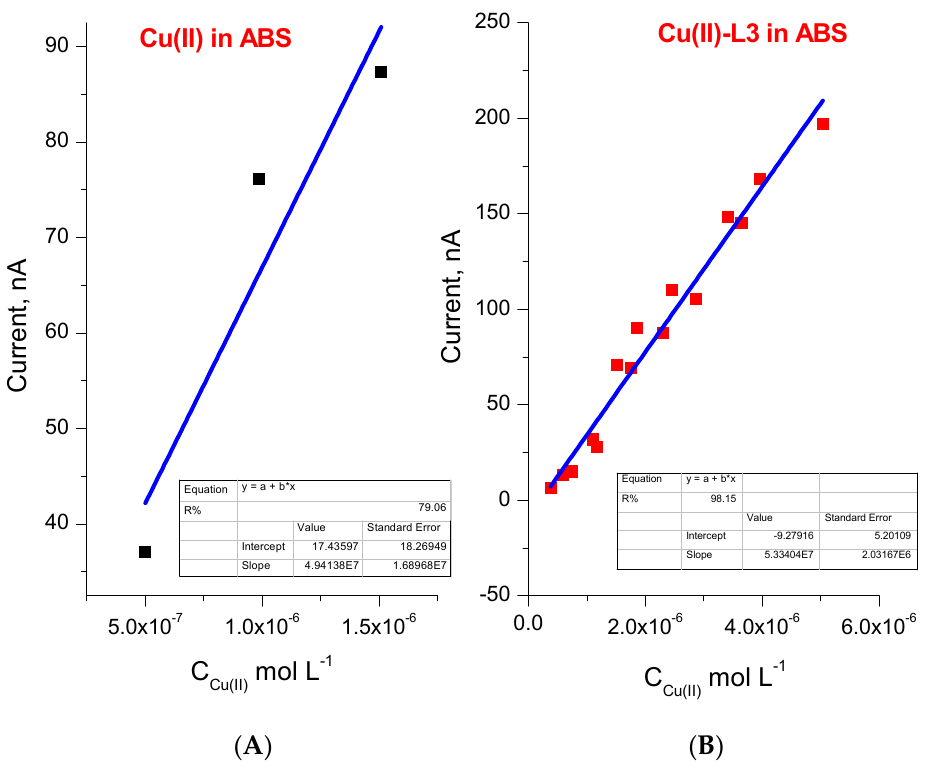
Figure 12. Plot of Ipc, nA vs. C Cu(II) , mol L − 1 of ( A ) free Cu (II) in ammonium buffer solution (ABS) and ( B ) Cu (II)-L3 with tenfold excess of azo-azomethine derivative.